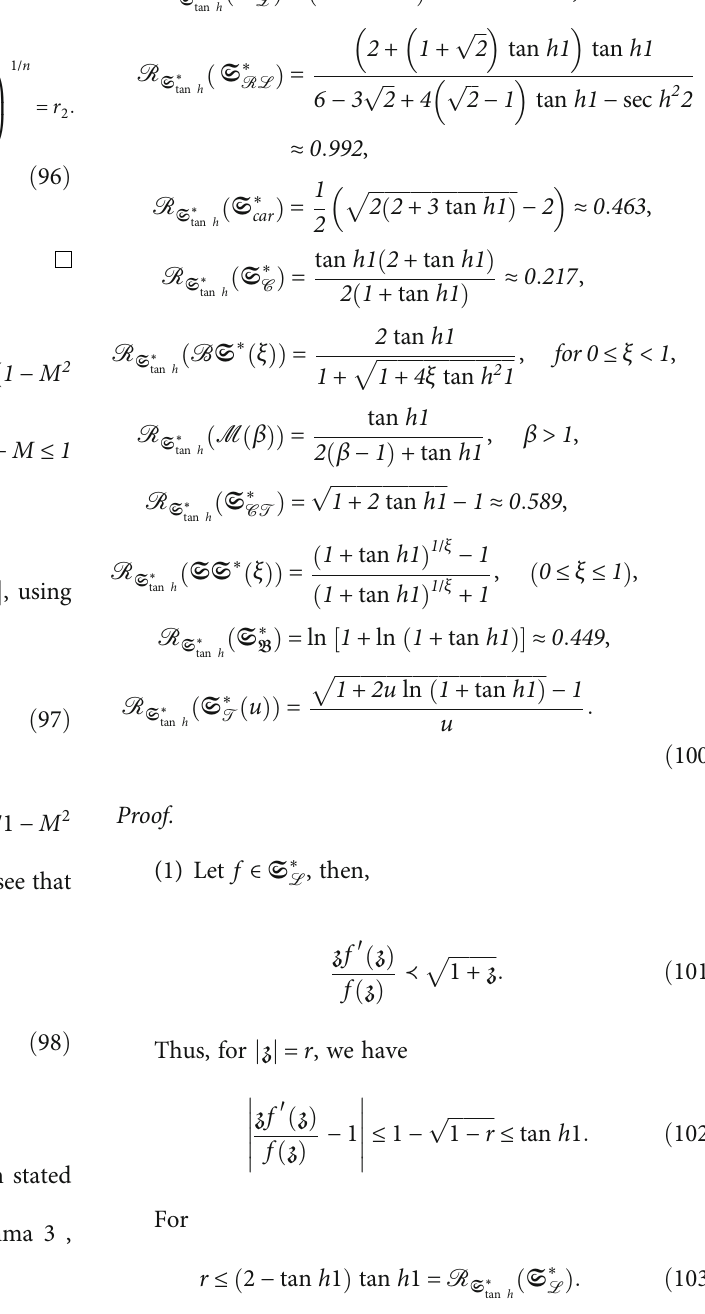
ffiffiffiffiffiffiffiffiffiffiffiffiffiffiffiffiffiffiffiffiffiffiffiffiffiffiffiffiffi